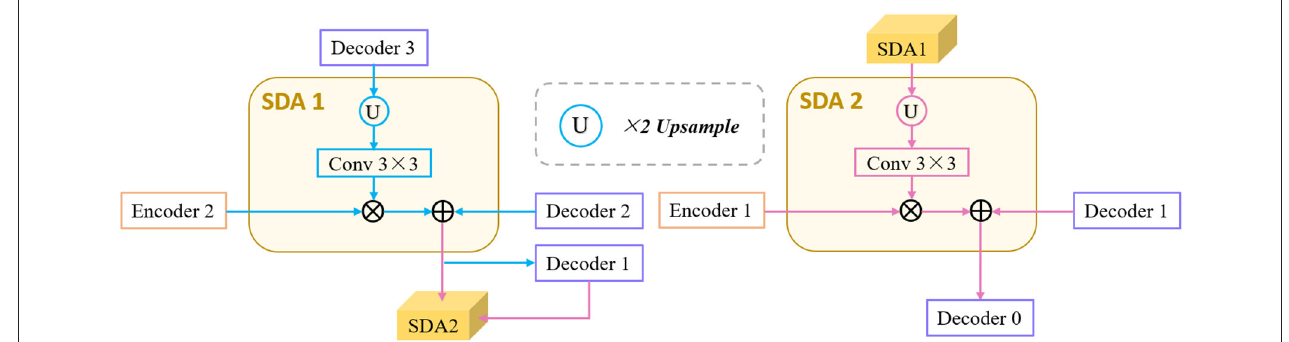
FIGURE 3 | Architecture of the proposed semantics-details aggregation module